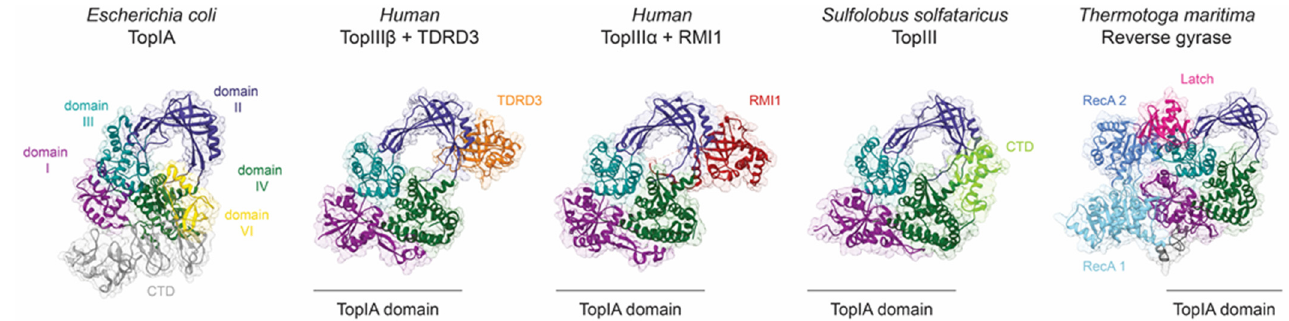
Figure 4. Structural elements, partners, or associated domains regulate topoisomerase IA activity. The domains I to IV of topoisomerase IA are coloured dark magenta, dark slate blue, dark cyan, and dark green. Additional domains of E. coli TopI (PDB 4RUL) located at the C-terminal end are coloured grey, and the Zn finger of domain VI interacting with domain DII appears in yellow. The catalytic domain of topoisomerase III and reverse gyrase adopts the typical topoisomerase IA toroidal fold. TDRD3 (orange) or RMI1 (red) are accessory proteins interacting mainly with the toroidal region of human TopIII β (PDB 5GVE) and TopIII ɑ (PDB 4CGY), respectively. Similarly, the C-terminal domain (CTD in light green) of TopIII from S. solfataricus (PDB 6KN8) interacts with the toroid domain. Reverse gyrase (PDB 4DDU) is composed of two RecA helicases domains (light and medium blue) separated from the Topo IA domain by the latch domain (deep pink).